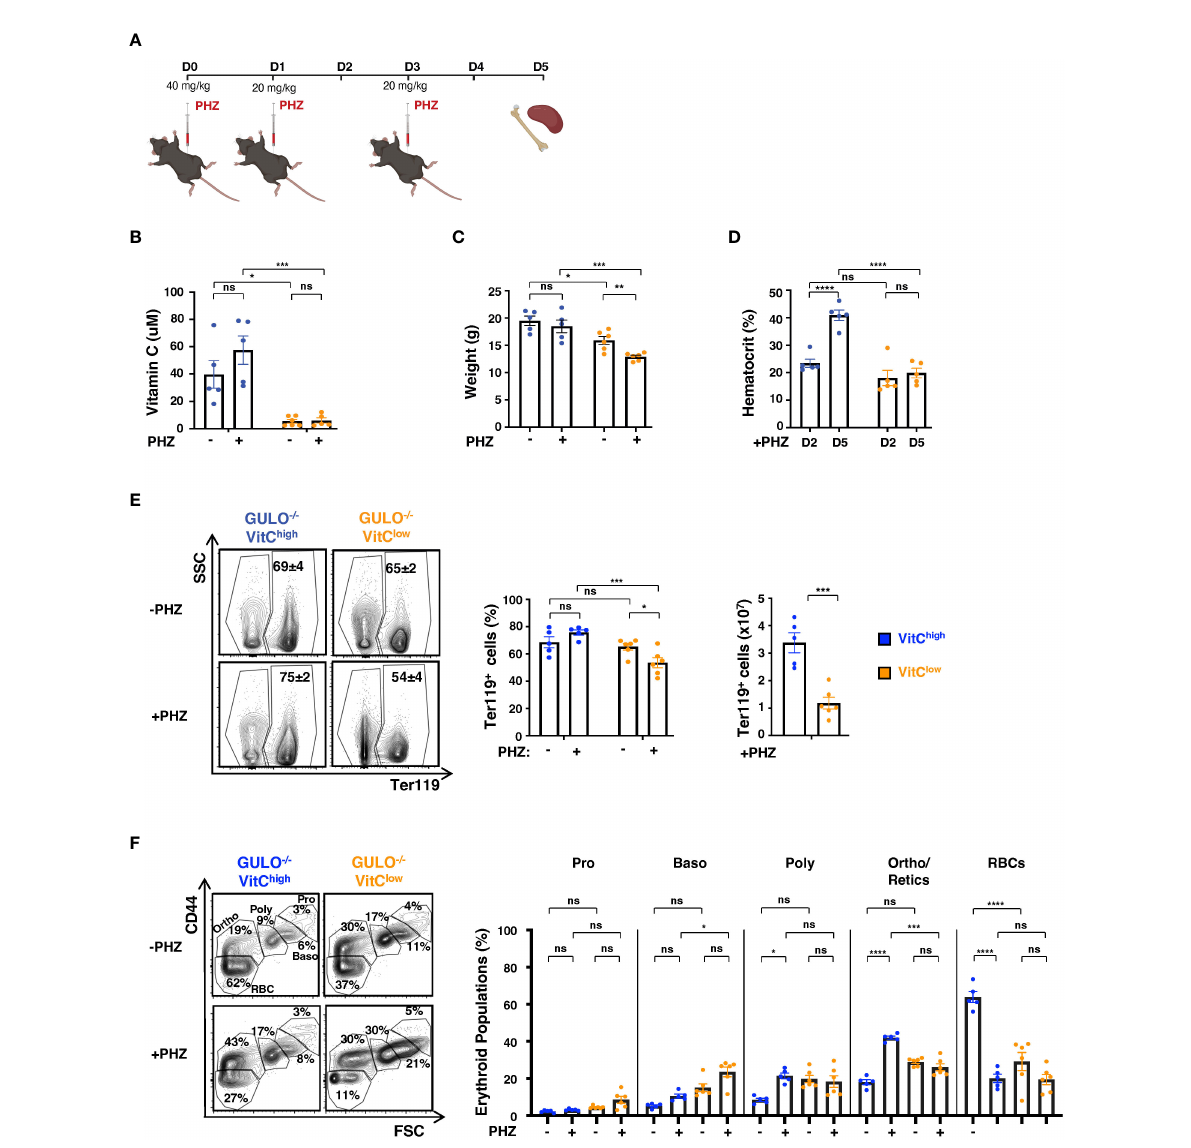
FIGURE 7 Hemolytic anemia results in changes in bone marrow erythroid differentiation in ascorbate-suf fi cient but not ascorbate-de fi cient GULO -/- adults. (A) Schema illustrating the experimental protocol used to induce hemolytic anemia in adult GULO -/- mice by phenylhydrazine (PHZ). PHZ was administered IP at a dose of 40mg/kg on day 0 and at 20mg/kg on days 1 and 3, and then mice were euthanized at day 5. (B) Plasma vitamin C concentrations were measured by HPLC in control and PHZ-treated GULO -/- VitC high and GULO -/- VitC low mice at day 5. Means ± SEM are presented (n=5-6 per group). (C) Weights of control and PHZ-treated GULO -/- VitC high and GULO -/- VitC low mice were measured at day 5 post-treatment. Means ± SEM are shown (n=5-6 per group). (D) Hematocrits were monitored in PHZ-treated GULO -/- mice on days 2 and 5 and means ± SEM are presented (n=5 per group). (E) The impact of PHZ-induced hemolytic anemia on Ter119 + BM cells was evaluated at day 5 in the indicated conditions. Representative contour plots, percentages, and absolute numbers of Ter119 + cells are presented. (F) The differentiation state of Ter119 + erythroblasts was evaluated as a function of CD44/FSC pro fi les, distinguishing proerythroblasts (Pro), basophilic erythroblasts (Baso), polychromatic erythroblasts (Poly), orthochromatic erythroblasts (Ortho), reticulocytes, and RBCs as indicated (left). The percentages of cells in each stage of erythroid differentiation were quanti fi ed in the indicated conditions at day 5 of PHZ-induced anemia (right). Statistical analyses were performed using an unpaired two-tailed t-test in panels (B – E) and a two-way ANOVA (Tukey ’ s test) in panel (F) . *p < 0.05; **p < 0.01; ***p < 0.001; ****p < 0.0001; ns, not signi fi